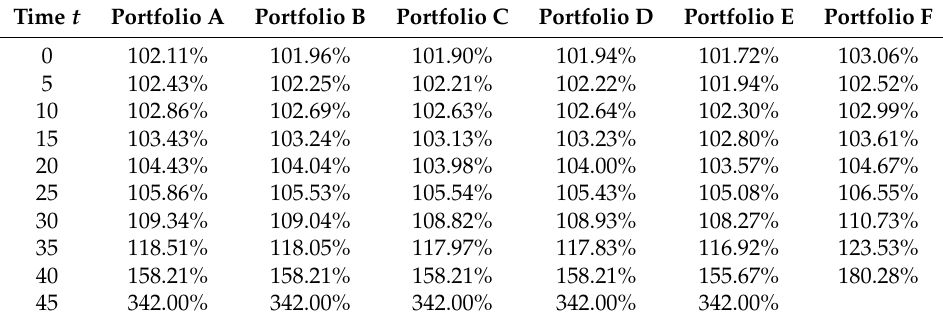
Table 12. Ninety-fifth percentile of PV t , as a % of E [ PV t ] .